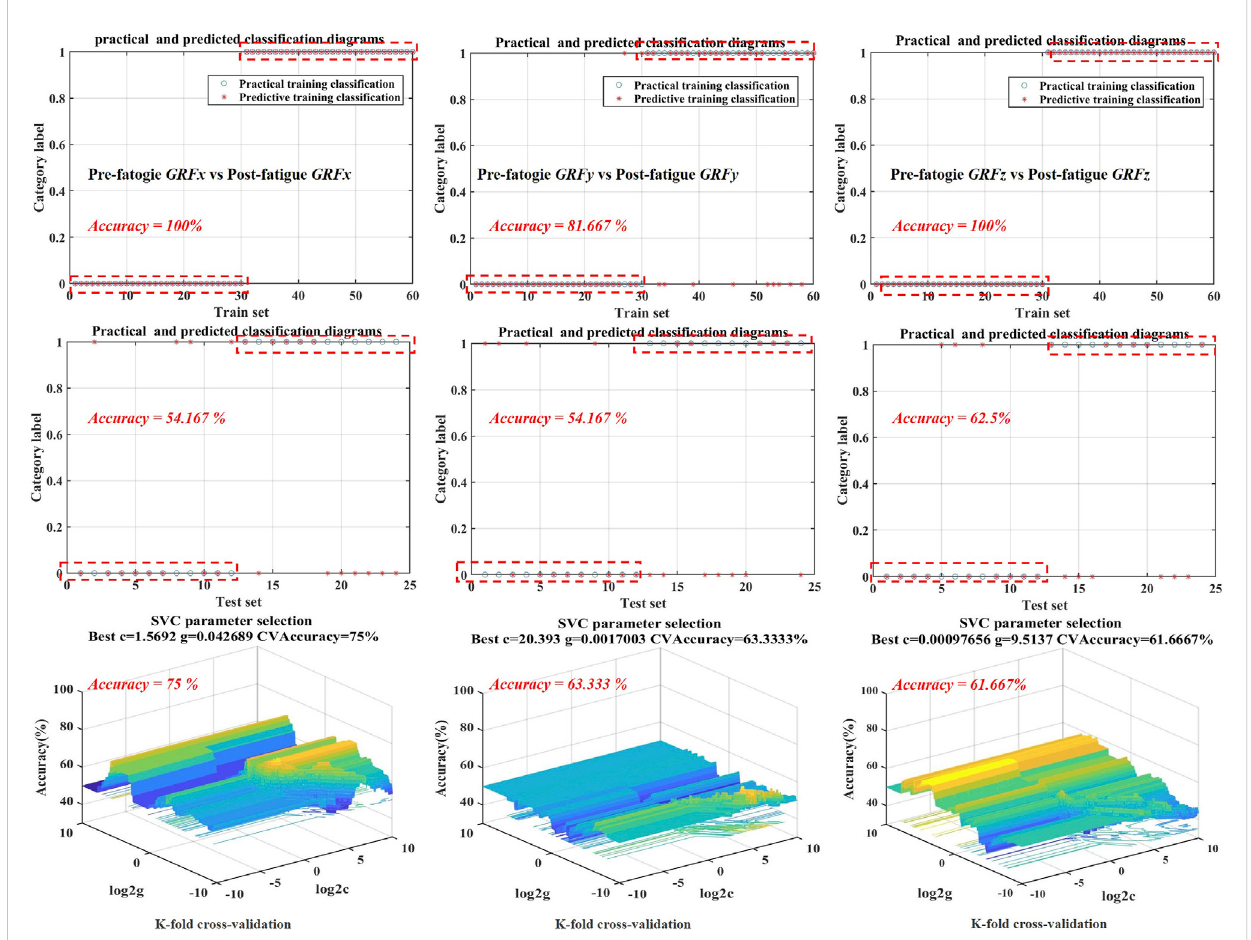
FIGURE 6 Training set,testsetand cross-validationmodelaccuracy visualization arebased onoptimal kernel functionselectionfor SVMmodels ofSFfor SVM models of SF x , SF y and SF z before and after Running-induced Fatigue Protocol Test. SFx: medial-lateral direction of SF, SFy: anterior-posterior direction of SF, SFz: vertical direction of